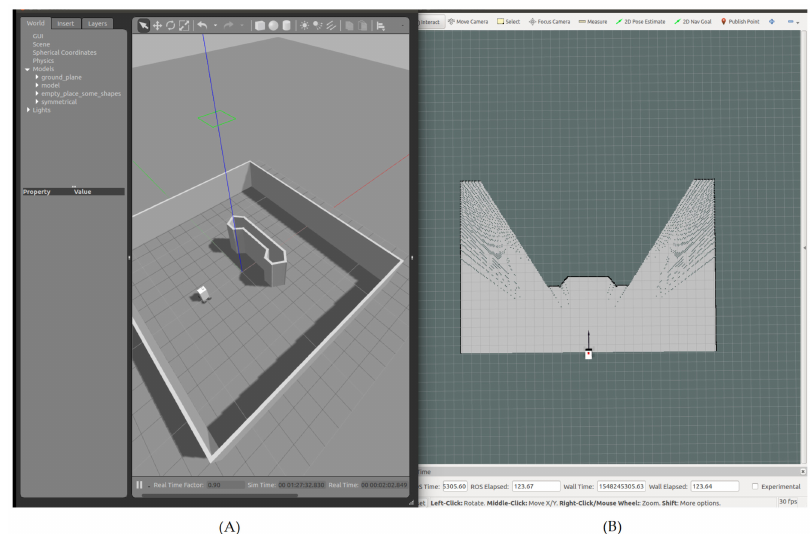
Figure 12. Simulation environment of the nonsatisfaction of the FST condition with the navigation area on Gazebo ( A ), and the simulated state of the robot on Rviz ( B ).